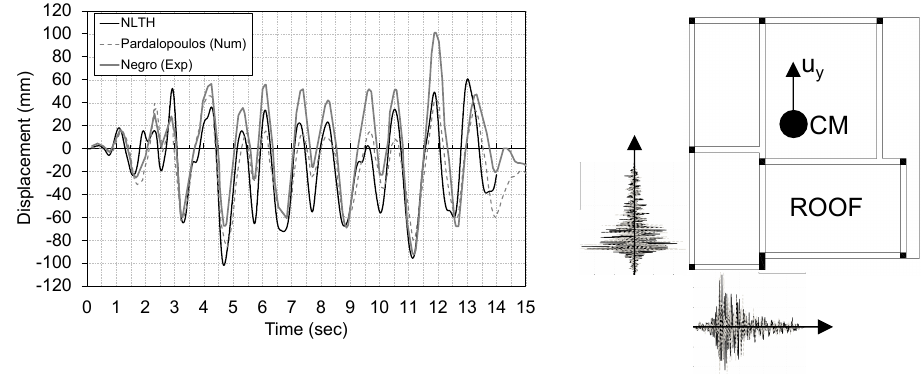
Figure 14. Validation of NLTH applied to the SPEAR frame, y–displacement at the roof.